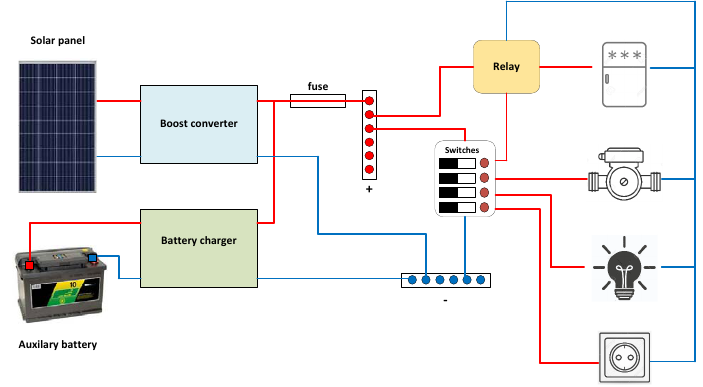
Figure 2. Connection of PV panel with camping-car